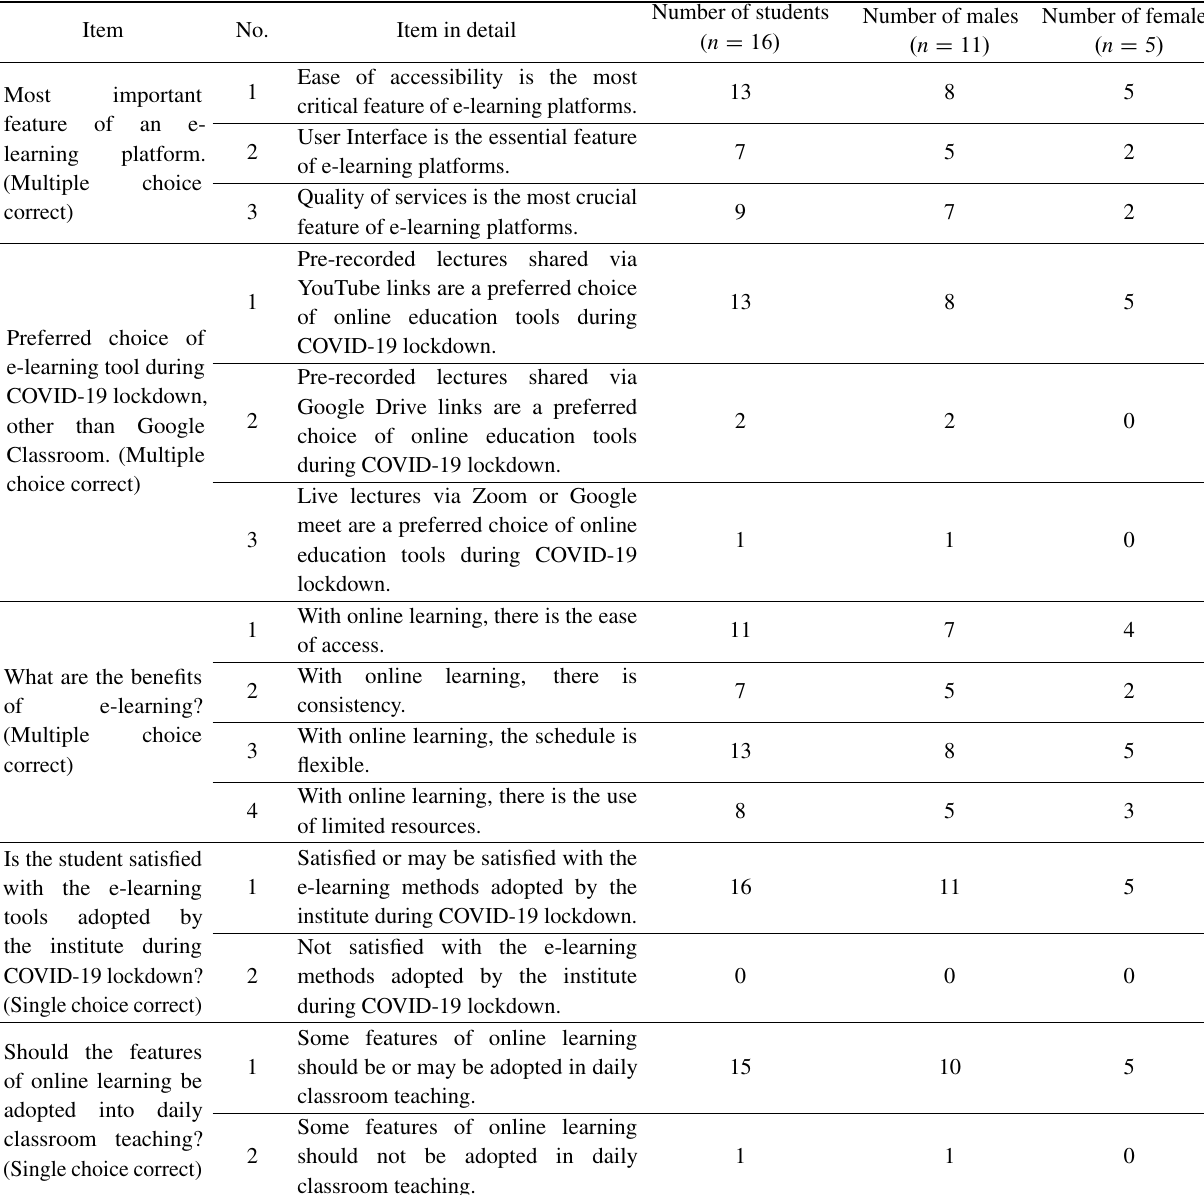
Table 2 Students’ response to survey conducted regarding e-learning practices adopted by teaching faculty of National Institution of Technology,